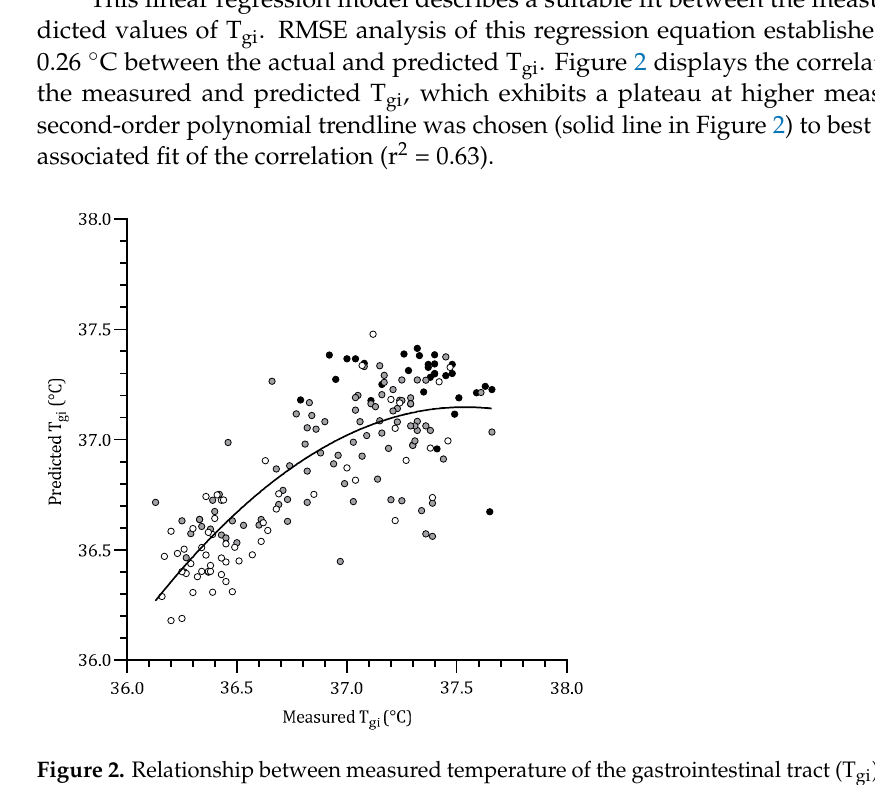
Figure 2. Relationship between measured temperature of the gastrointestinal tract (T gi ) and predicted T gi using Equation (1). Measurements and predictions based on skin temperatures were obtained while participants were exposed to three ambient temperatures: 22 ◦ C (white dots), 25 ◦ C (grey dots), and 35 ◦ C (black dots). A second-order polynomial trendline (y = − 0.4464x 2 + 33.512x − 591.75) represents the best fit (r 2 = 0.63).